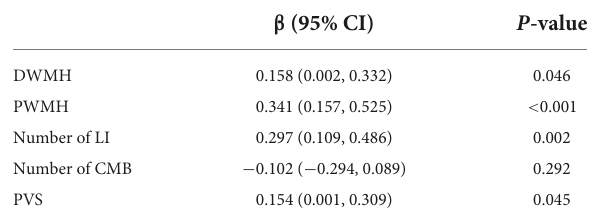
TABLE 1 Multivariate linear regression analysis for free water in white matter in patients with cerebral small vessel